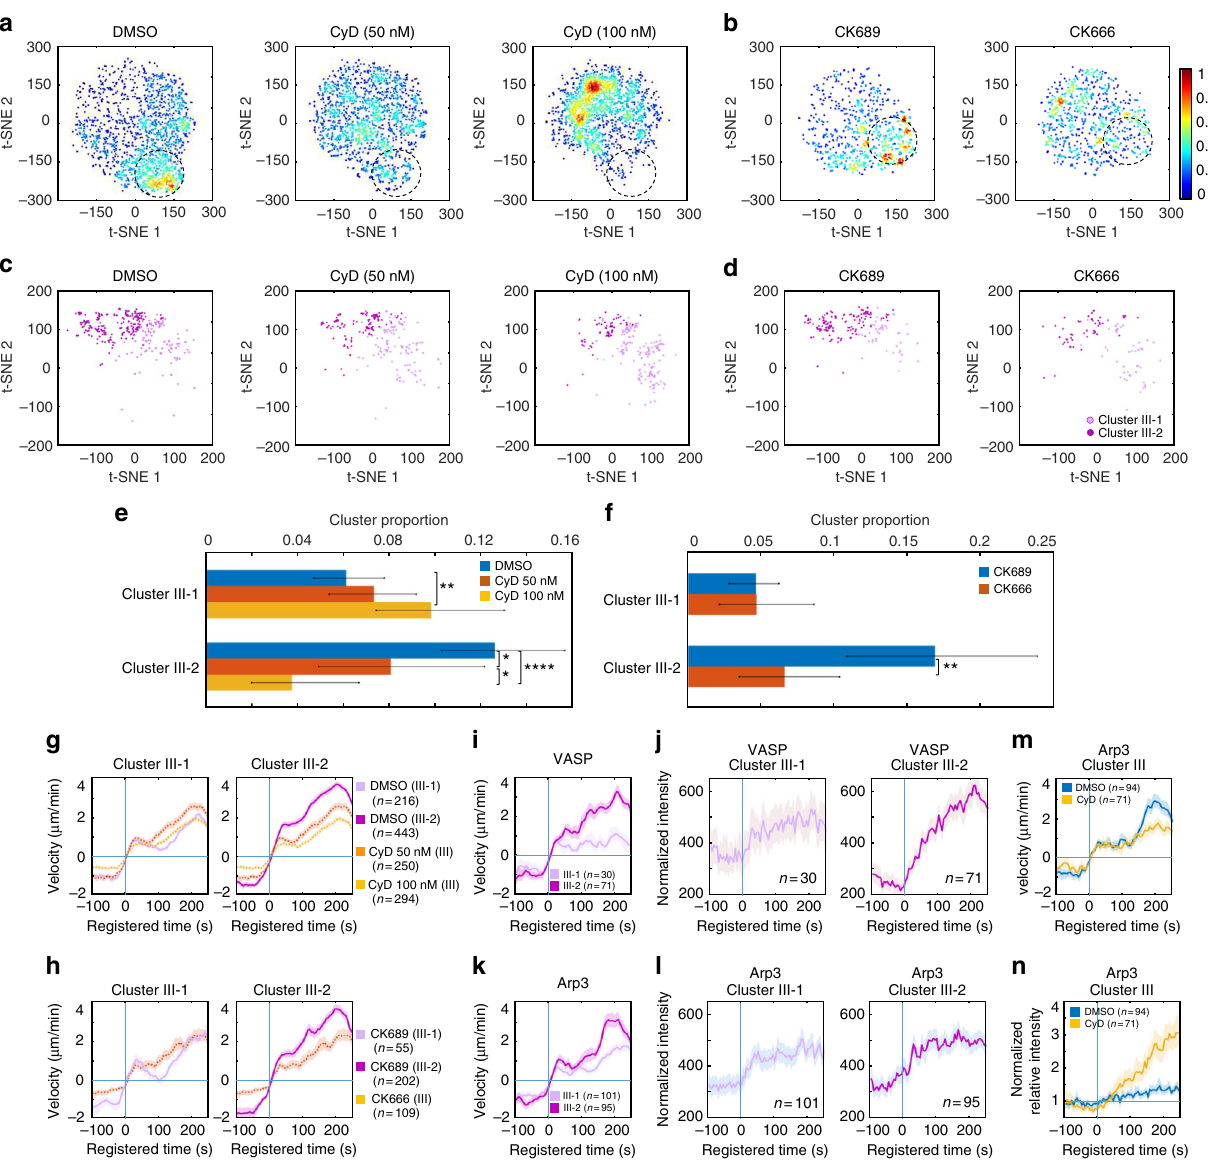
Fig. 7 Functional validation of the differential coordination between Arp2/3 and VASP in strong accelerating protrusion. a , b t-SNE plots of the denoised protrusion velocity time series of the whole sample overlaid with the density of data. c , d t-SNE plots of the denoised velocities of the sub-clusters (Cluster III-1 and III-2) in Cluster III. e , f Comparison of the proportion of Cluster III-1 and III-2 upon Cytochalasin D treatment ( e ) or CK666 treatment ( f ). The error bars indicate 95% con fi dence interval of the mean of the cluster proportions. * p < 0.05, ** p < 0.01, and **** p < 0.0001 indicate the statistical signi fi cance by bootstrap sampling. The numbers of cells used in this analysis are 22 (DMSO), 16 (CyD 50 nM), 20 (CyD 100 nM) and 10 (both CK689 and CK666), respectively. g , h Averaged velocity time series sampled in Cluster III (Cytochalasin D ( g ) or CK666 ( h )), Cluster III-1 and Cluster III-2 (DMSO ( g ) or CK689 ( h )). i – l Averaged velocity time series and normalized fl uorescence intensity time series of Cluster III-1 and Cluster III-2 from unperturbed VASP- expressing cells ( i , j ) or Arp3-expressing cells ( k , l ). m , n Averaged velocity time series ( m ) and normalized fl uorescence intensity time series of Cluster III ( n ) in Arp3-expressing cells upon treatment of DMSO or Cytochalasin D (100 nM). All time series are registered with respect to protrusion onset ( t = 0). Solid lines indicate population averages. Shaded error bands indicate 95% con fi dence intervals of the mean computed by bootstrap sampling. n indicates the number of time series in each